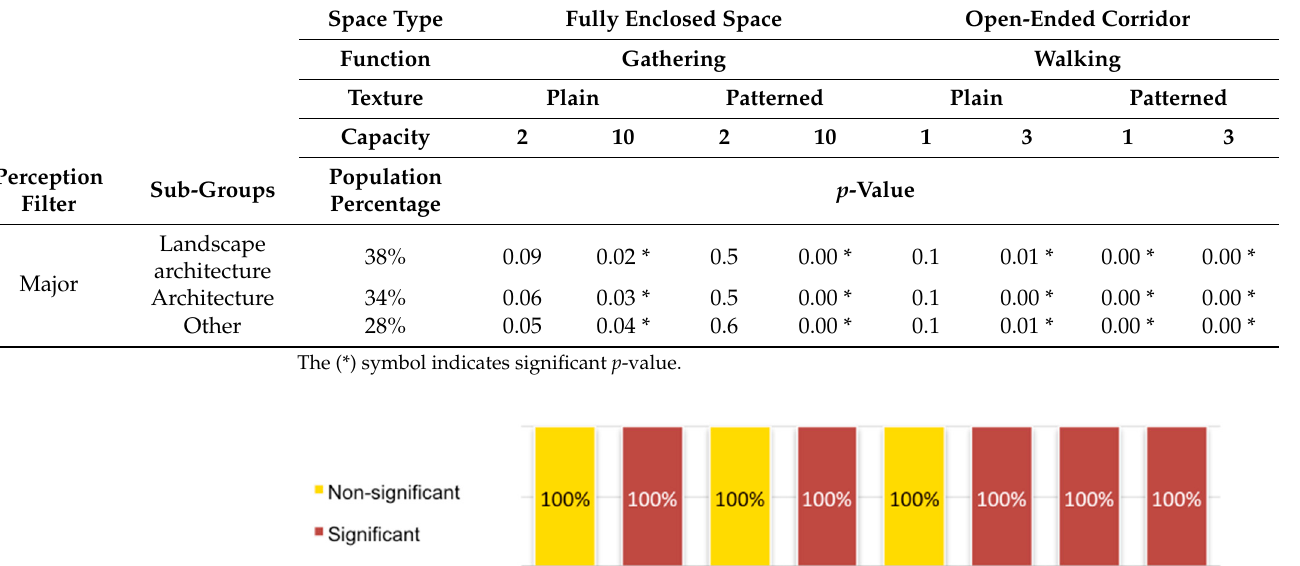
Table 5. Major perception filter and comparisons of space size variations between IVRIE and DT systems.